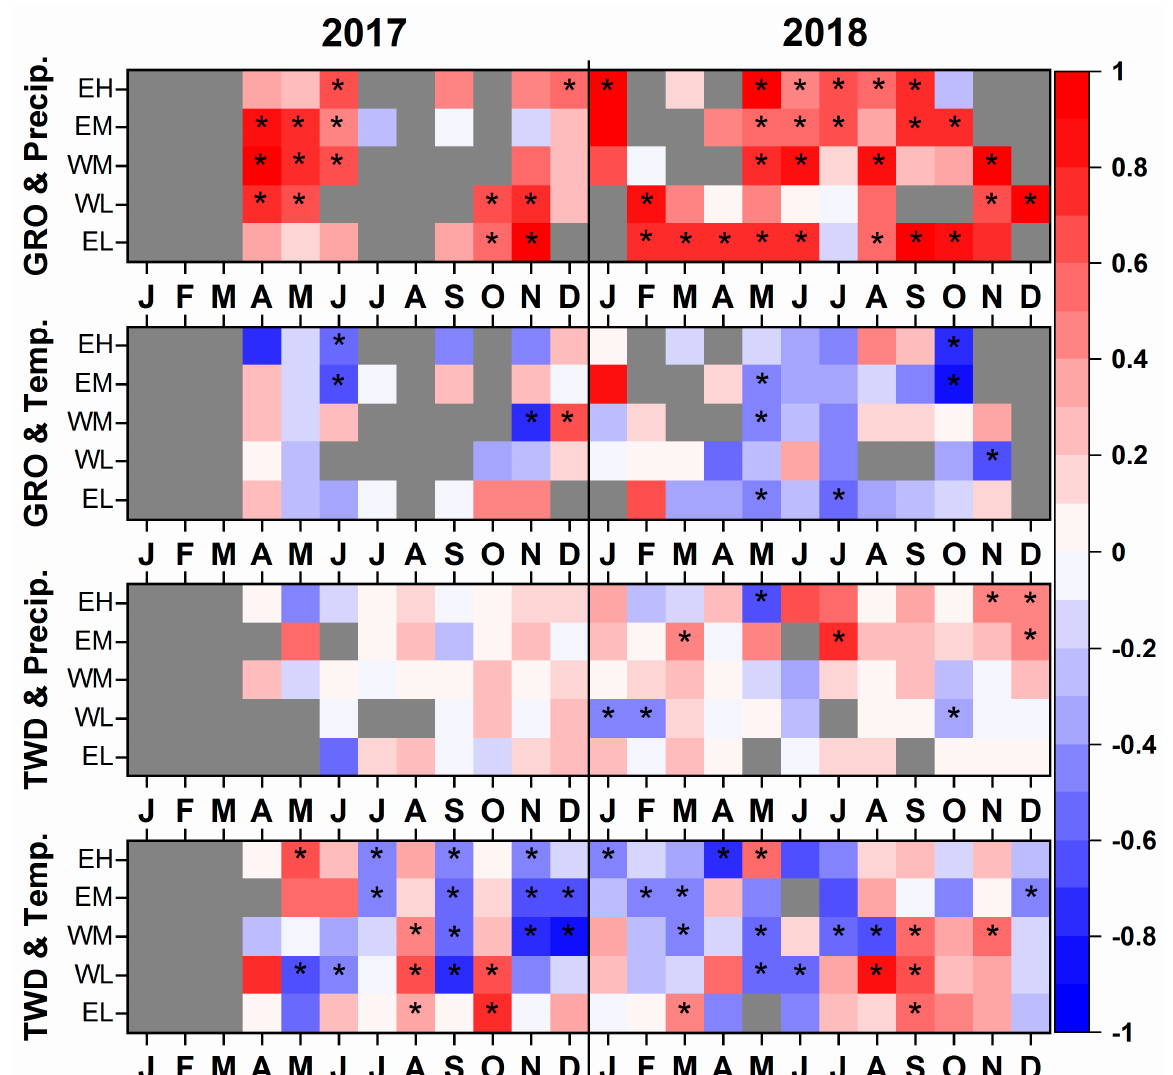
Figure 5. Monthly correlation coefficients of temperature and precipitation with GRO and TWD. Significant correlations ( p = 0.05) are marked with an asterisk. Correlations are based on daily data (Daily growth rates are depicted in Figure S2). Grey fields are months where no GRO or TWD was detected.